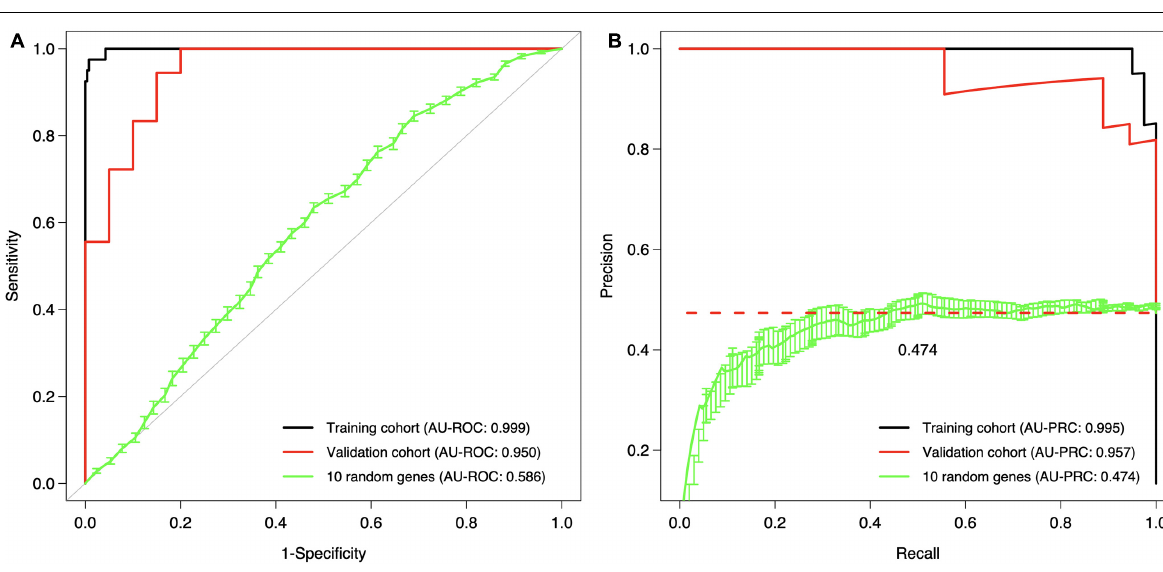
FIGURE 6 | Validation and training cohort accuracies of the 10-gene signature. (A) ROC, (B) PRC. The Lasso model was first estimated based on the full training dataset using the 10 genes as features, and then the estimated model was applied to the validation cohort. The training cohort model accuracy is overoptimistic as no cross validation was used and the training and test data are the same; see Figure 5 for cross-validated training cohort model accuracy. For comparison, we randomly selected 10 genes 100 times, estimated 100 Lasso models in the training cohort, and then tested these random gene classifiers on the validation cohort. The 10 random gene curve shows the average performance of the random classifiers, and the error bars show the standard error of the mean (SEM). In panel (B) , the dashed horizontal line corresponds to a theoretical random classifier with AU-PRC =